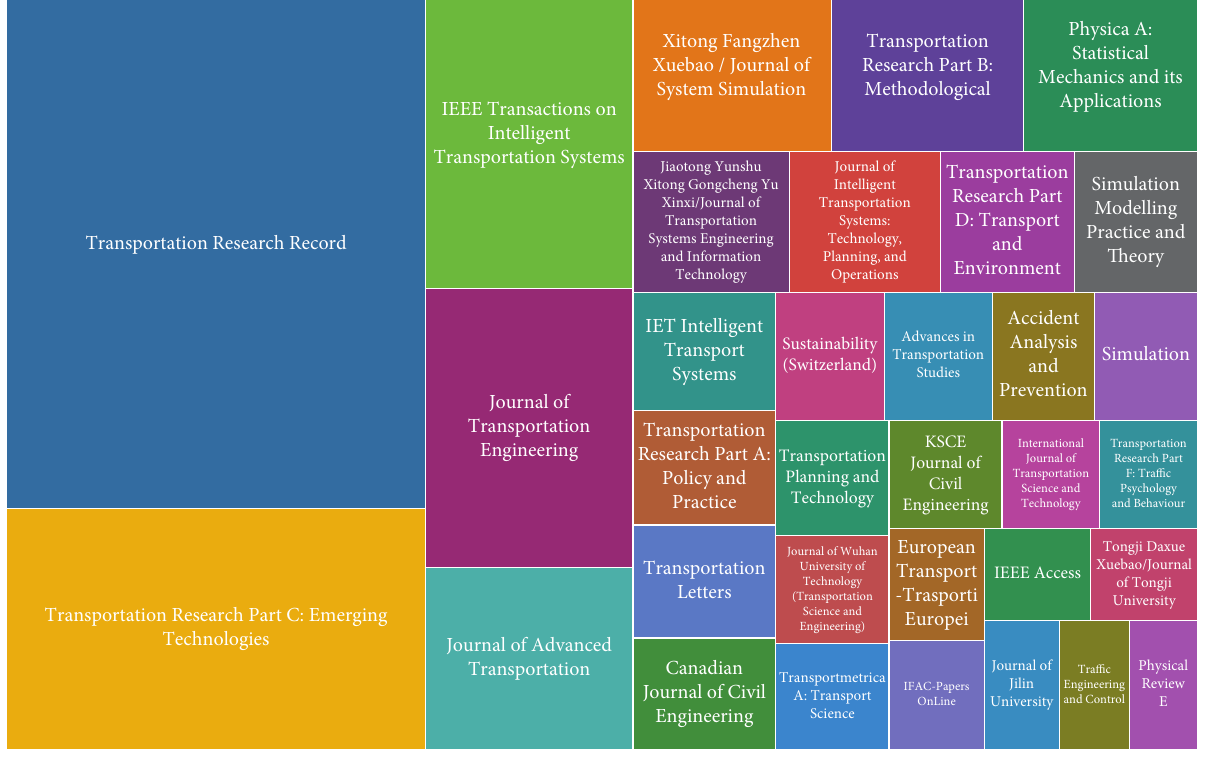
Figure 3: Traffic microsimulation work share of the journals with at least 15